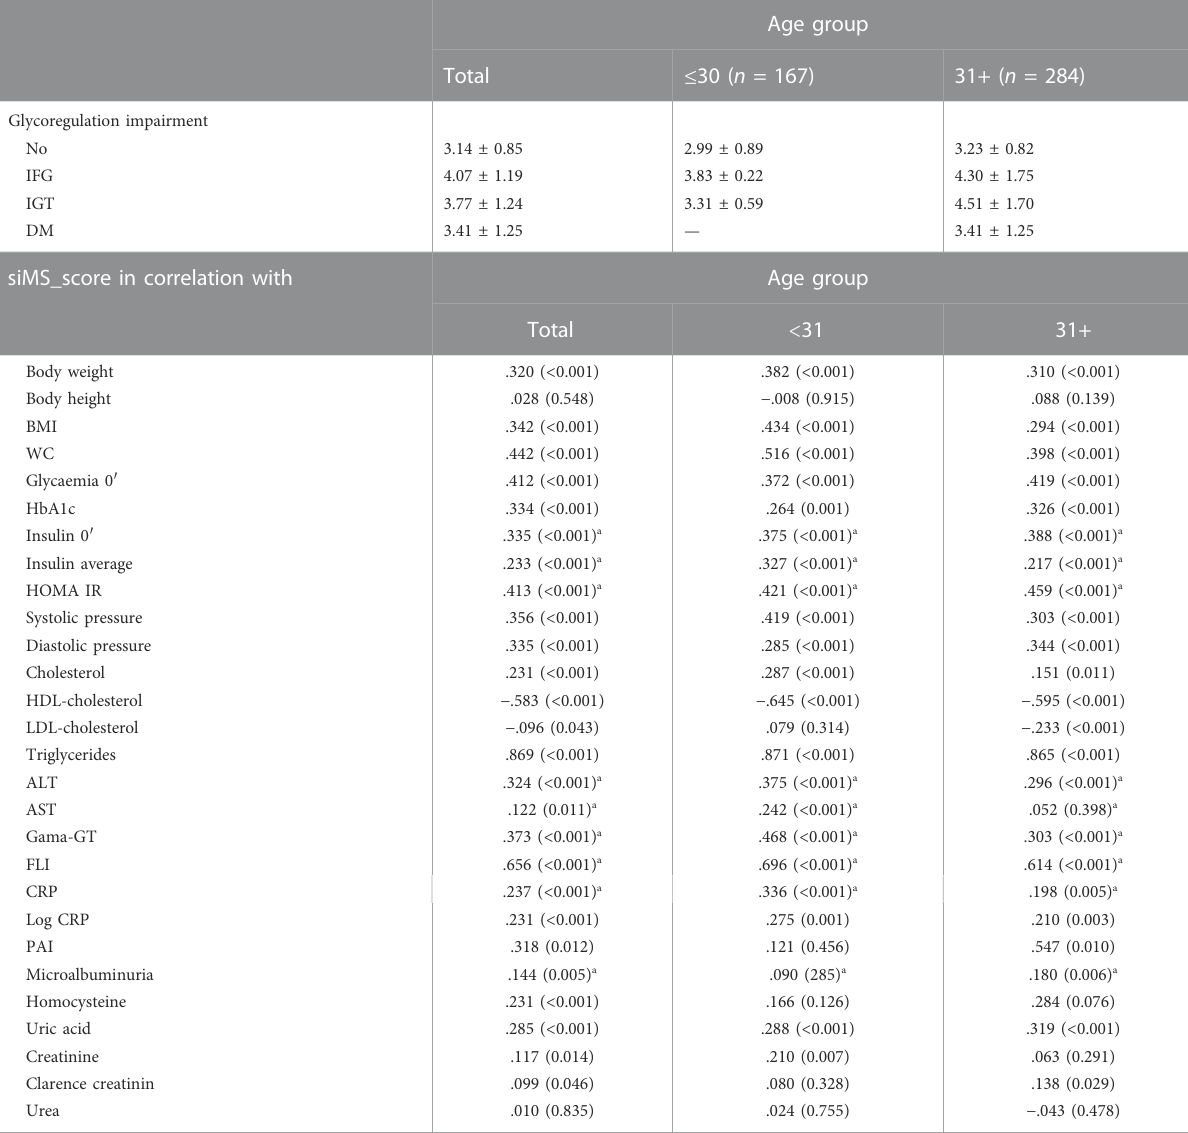
TABLE 2 Value of siMS score in different glycoregulation impairments and correlations with other